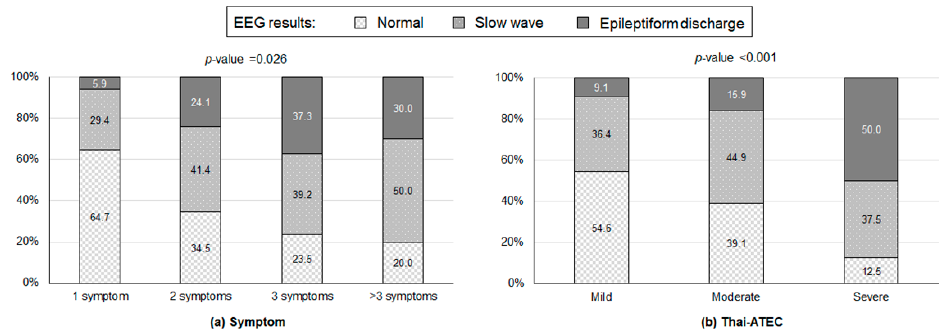
Figure 1. Electroencephalography (EEG) results according to ( a ) the number of diagnosed autism spectrum disorder (ASD) symptoms and ( b ) Thai-ATEC (Thai autism treatment evaluation checklist) results. p -Values were obtained from Fisher’s exact tests.